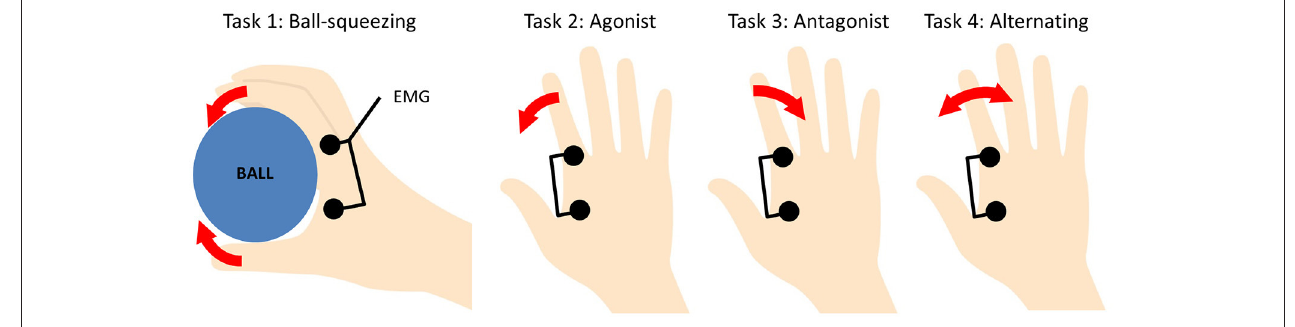
FIGURE 1 | Schematic description of the tasks. In Task 1, a ball with 8-cm diameter (shown in blue) was squeezed with the entire hand. In the other tasks, the right index finger was moved in a specified direction (Tasks 2–4).